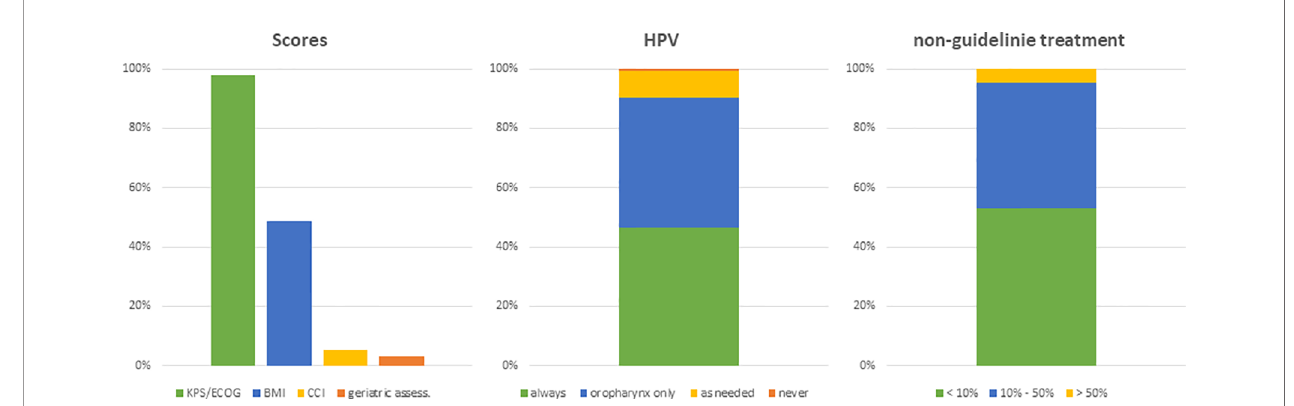
FIGURE 2 | Bar charts indicating the usage of different scores in patient assessment (n=131), the evaluation of the HPV status (n=130) and the assumed proportion of patients not treated based on current guidelines (n=128). (KPS, Karnofsky performance status; BMI, body mass index; CCI, Charlson Comorbidity Index; HPV, human